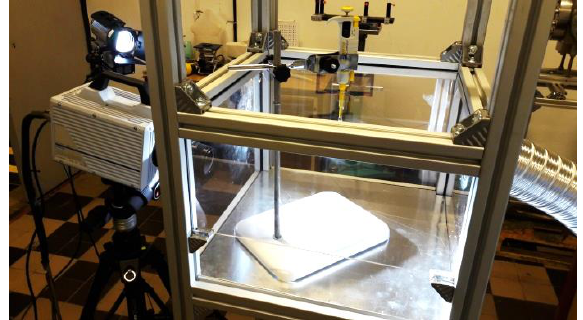
Fig. 2. Drop test rig for measurements in ambient conditions used in the study As shown in Fig. 2 the operator is separated from the drop test area with polycarbonate sheets. The test volume restricted by polycarbonate walls is continuously scavenged by a ventilation system, which is responsible for removing fumes created during combustion of hypergolic propellants. The falling droplet and ignition are captured using the Pho- tron Fastcam SA-1.1 camera at a frame rate of 10000 fps, which requires an additional light source to visualize the droplet and the instant of collision.